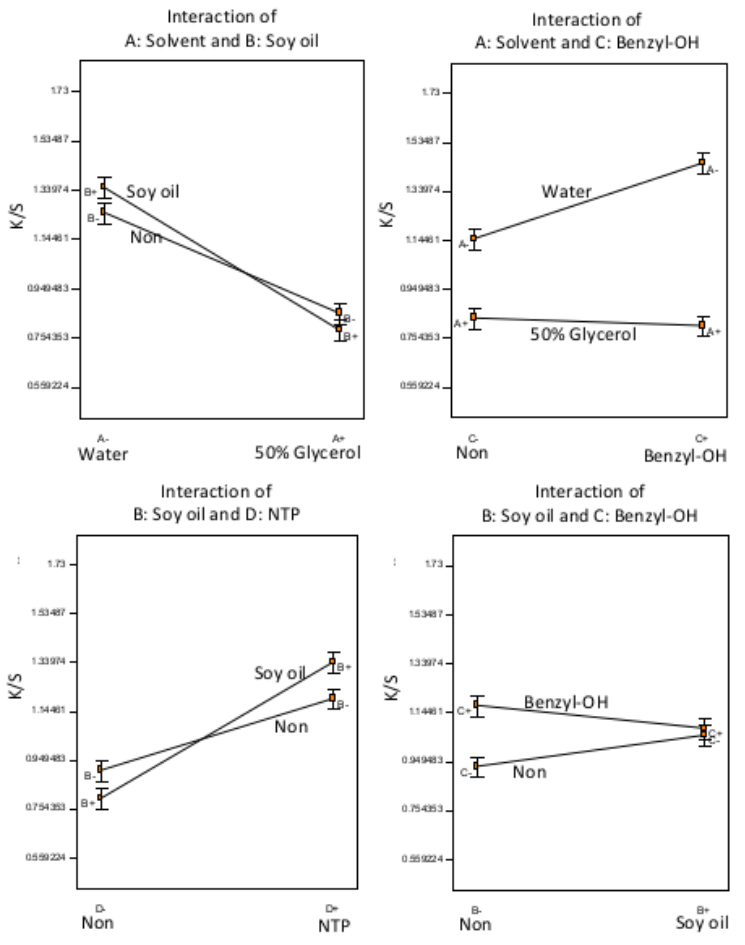
Figure 4. Statistical inference of Experiment C: significant factorial